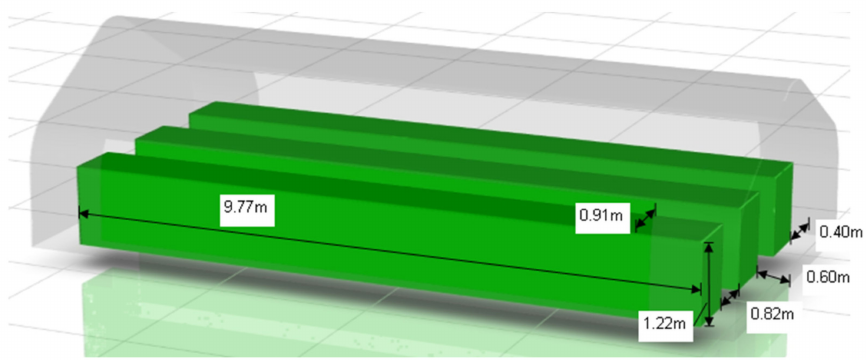
Figure 3. Dimensions of three simulated plant rows located inside a freestanding high tunnel.